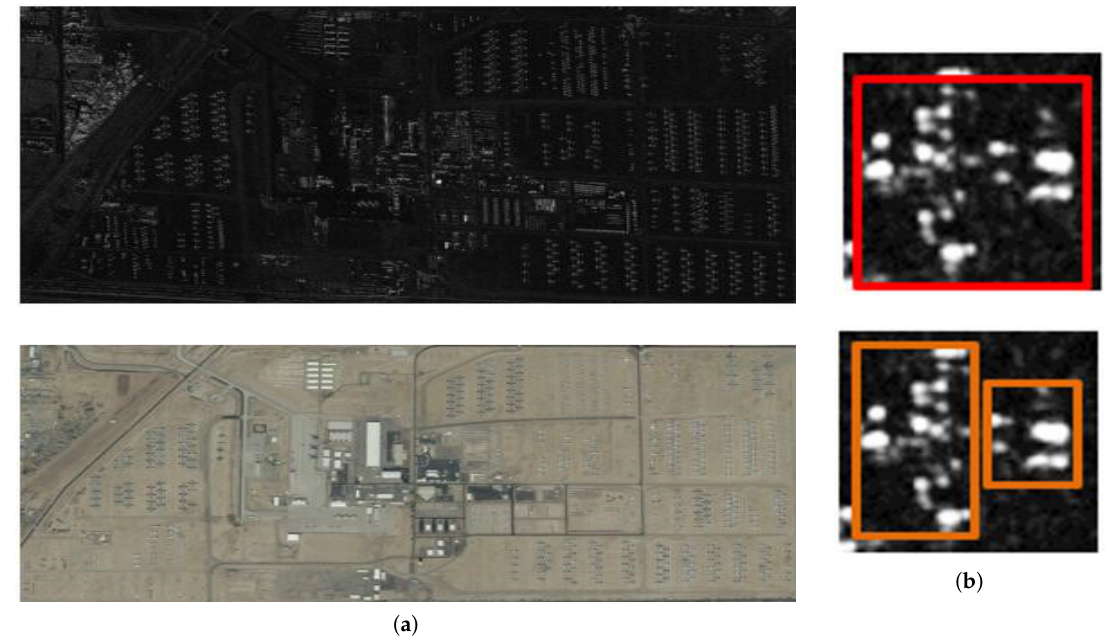
Figure 7. TerraSAR-X SAR data used in the experiments. ( a ) The original SAR imagery and the corresponding optical image; ( b ) The callout image: a global bounding box and two component bounding